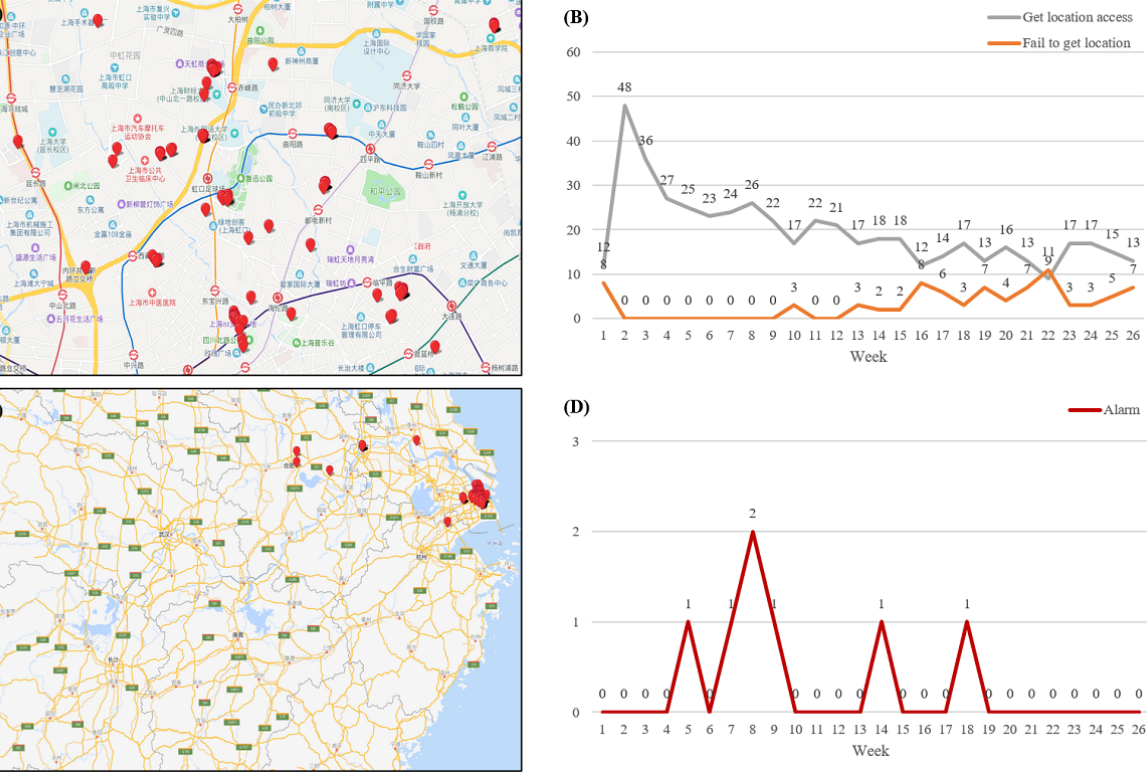
Table 2. Use of CAREs features on both webpage and app ends. Social workers (webpage end)